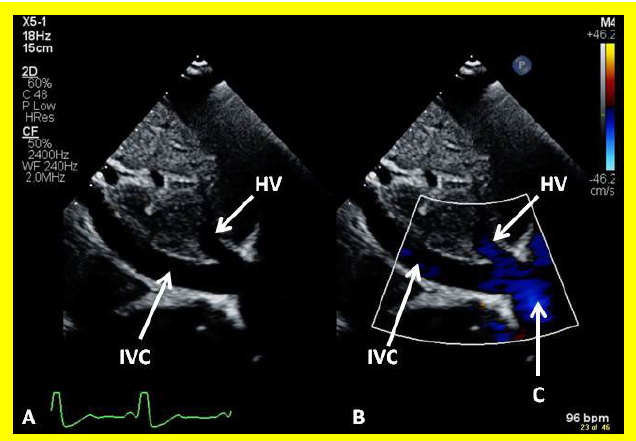
Figure 47. Selected video frames demonstrating connection between the inferior vena cava (IVC) and the conduit (C) by 2D ( A ) and color flow imaging ( B ); note that the IVC–C junction is wide open.